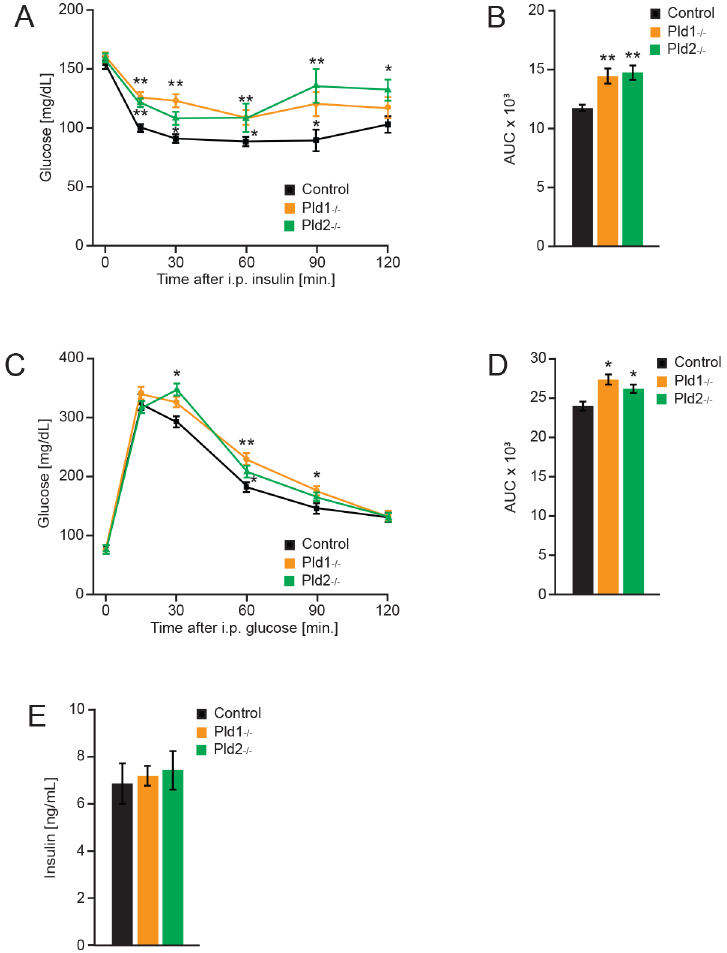
Fig 6. Deletion of Pld1 or Pld2 promotes insulin resistance and glucose intolerance. A) Insulin tolerance test in Pld1 -/- , Pld2 -/- and control mice at 16 weeks old. n = 7 for control (black), n = 6 for Pld1 -/- (orange), n = 8 for Pld2 -/- (green). B) Area under the curve for the insulin tolerance test. C) Glucose tolerance test in Pld1 -/- , Pld2 -/- and control mice at 18 weeks old. n = 12 for control (black), n = 10 for Pld1 -/- (orange), n = 12 for Pld2 -/- (green). D) Area under the curve for the glucose tolerance test. E) Insulin levels in circulation of mice with indicated genotypes at 20 weeks old. n = 8 males for control (black), n = 6 males for Pld1 -/- (orange), n = 8 males for Pld2 -/- (green). Data represented as mean +/- S.E.M., * p < 0.05, ** p < 0.01, *** p <